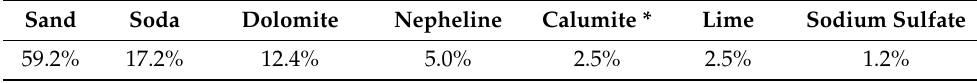
Table 1. Composition of the used batch in weight percentage. Sand Soda Dolomite Nepheline Calumite * Lime Sodium Sulfate 59.2% 17.2%